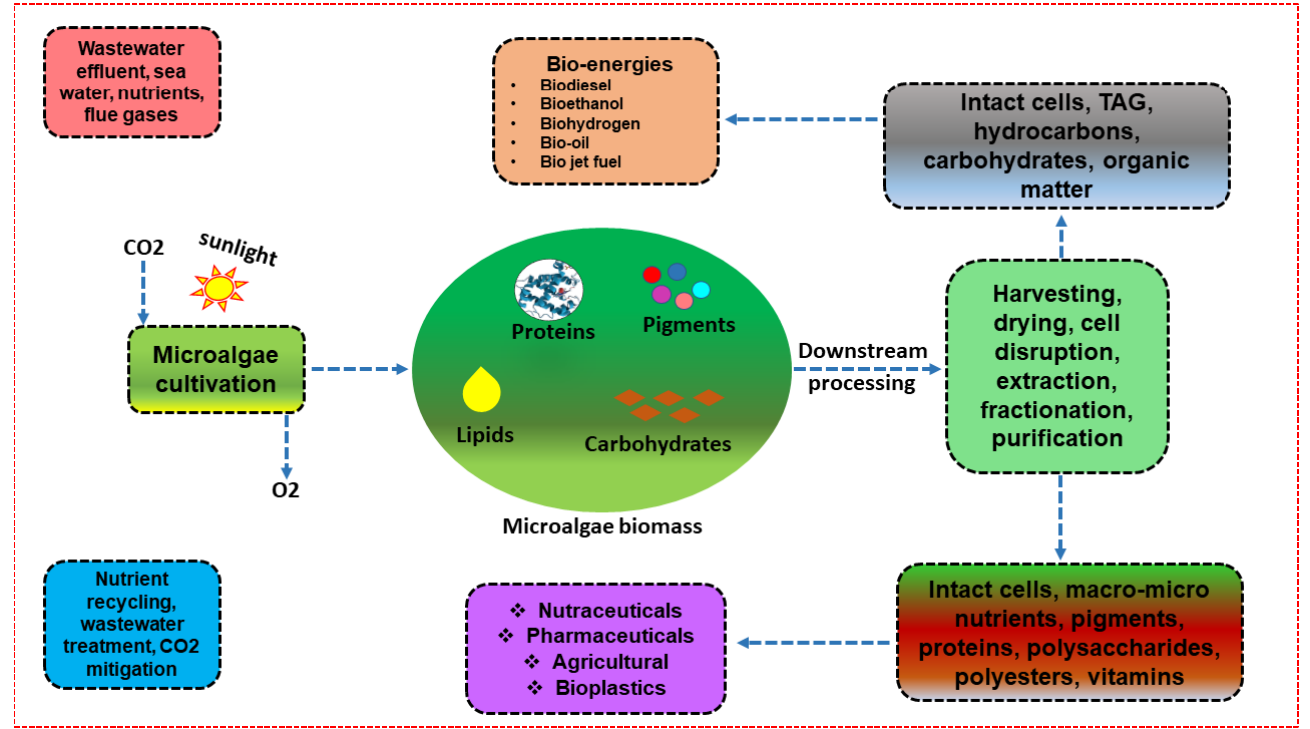
Figure 1. Conceptualization of microalgae biorefinery.